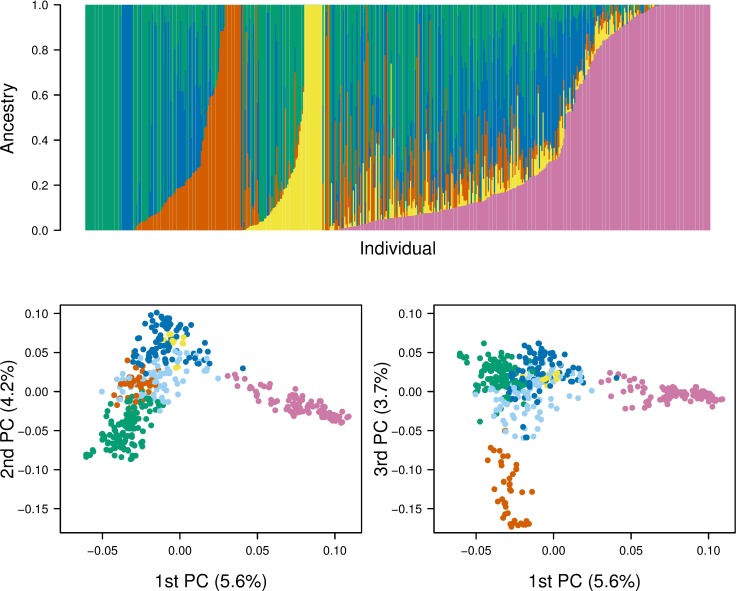
Genetic structure of the diversity panel.A—the ancestral fractions estimated for each accession in software ADMIXTURE for the number of ancestral populations K = 5, indicated with five colors. B—the results of the principal component analysis of the genotyping data, superimposed colors indicate the dominant ancestral fraction of the genotypes (value ≥ 0.5) and are equivalent to the colors used in A, except for light blue which indicates the genotypes for which no ancestral fraction was dominant.